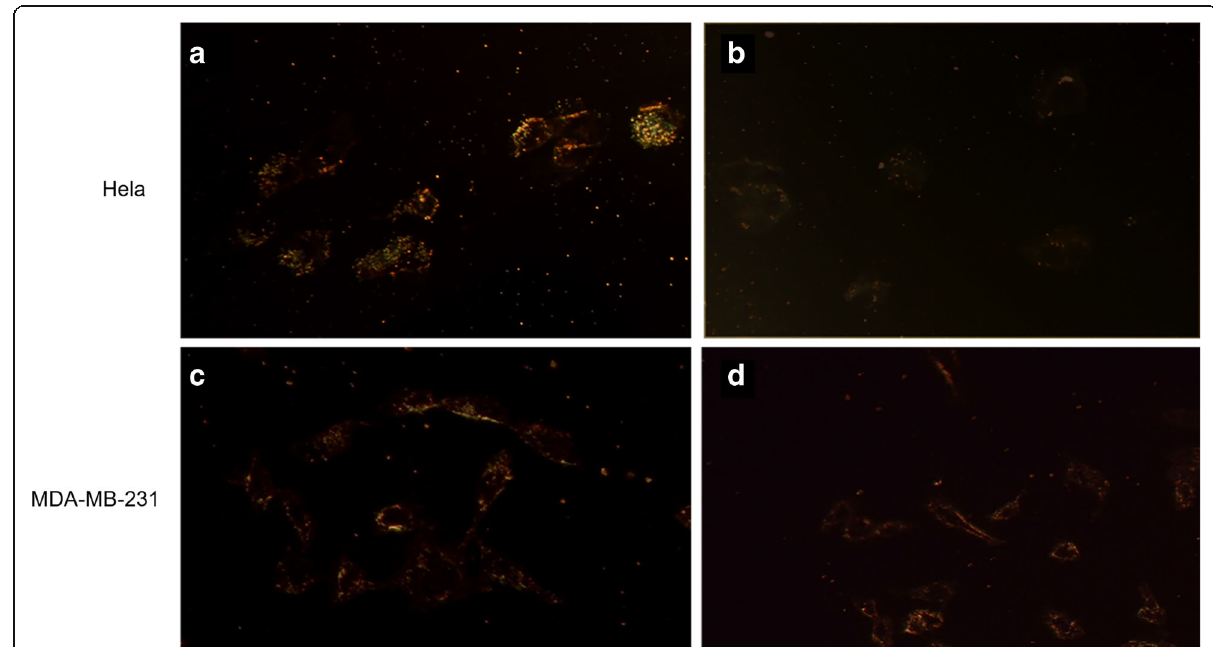
Fig. 5 Dark-field light-scattering images of two cell lines at × 20 magnification after incubation with CTAB-GNRs and peptide-f-GNRs for 2 h. The HeLa (as cancer cells with high level of α v β 3 integrins) cells incubated with peptide-f-GNRs ( a ) and CTAB-GNRs ( b ). The MDA-MB-231 (as cancer cells with low level of avb3 integrins) cells incubated with peptide-f-GNRs ( c ) and CTAB-GNRs ( d ). It seems that peptide replacement promotes the cellular uptake of peptide-f-GNRs